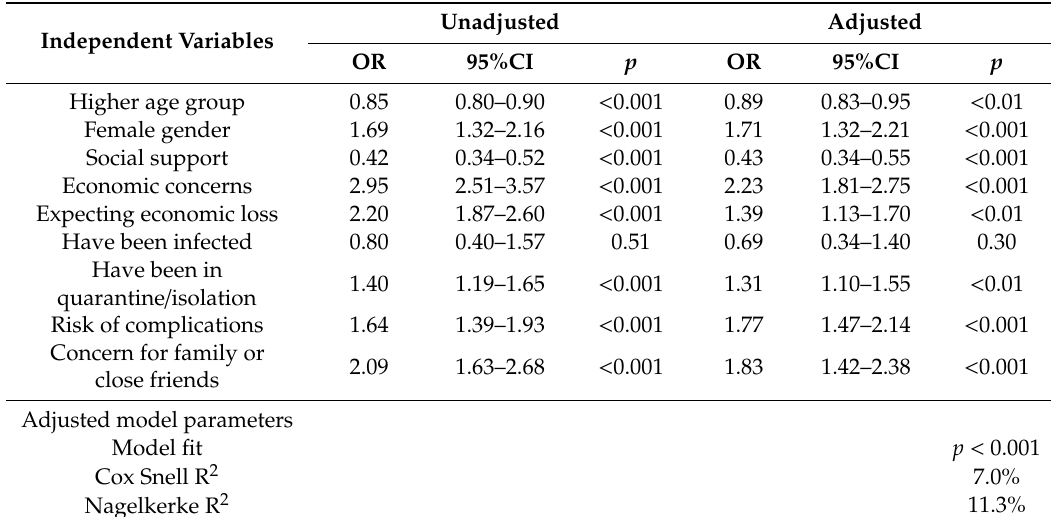
Table 2. Associations with current symptom-defined post-traumatic stress disorder (PTSD) ( n = 4527). Independent